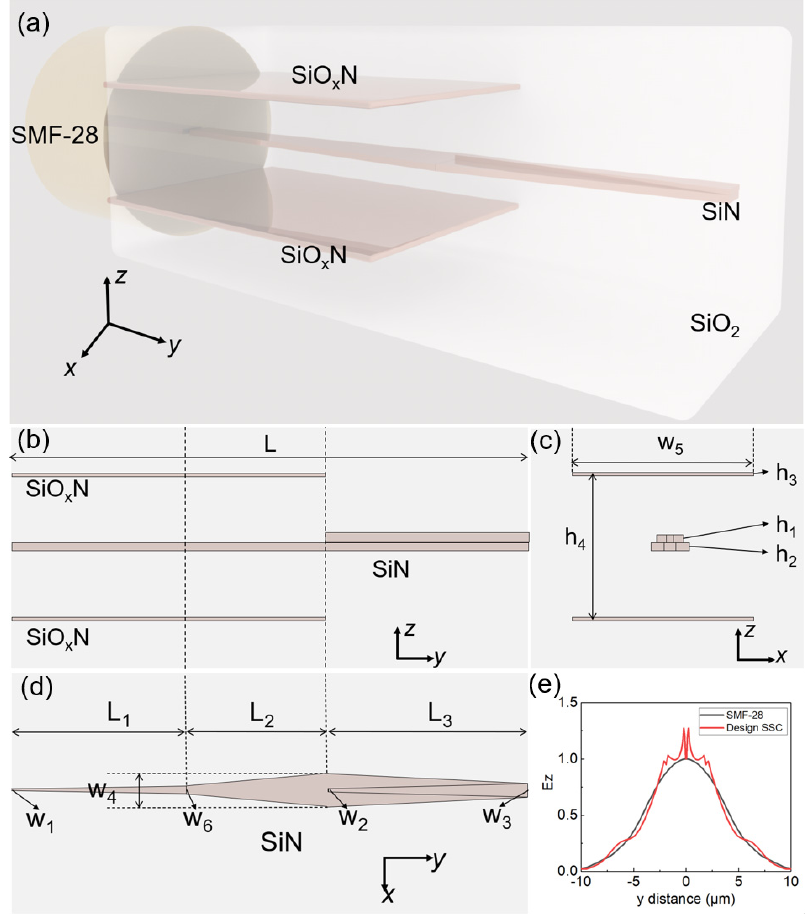
Figure 1. ( a ) A 3D view of the edge coupler; ( b ) the front view of the end-coupling structure; ( c ) the coupler geometry of the end facet; ( d ) the geometry of the SSC; ( e ) the E z field distribution at the end facet of the fundamental TM mode along the z-axis compared to the TM0 mode of the SMF-28.